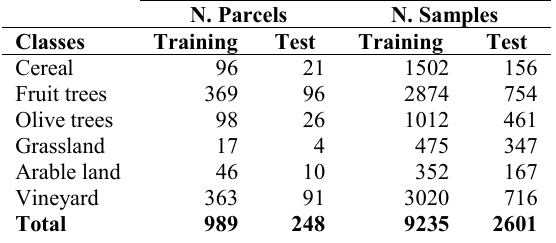
Table 1. Distribution of the number of parcels and samples among the different classes, training and testing sets.